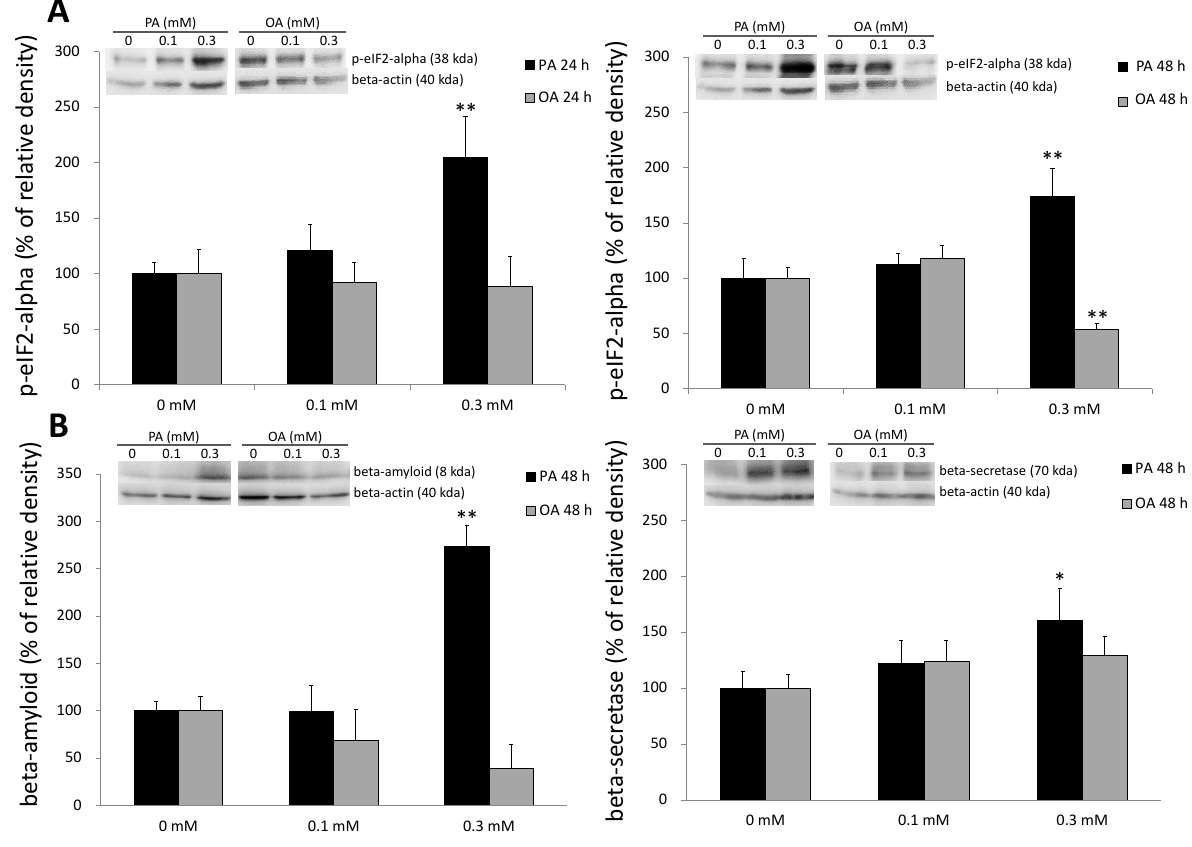
Figure 5. Effects of palmitic acid (PA) and oleic acid (OA) on Alzheimer’s disease pathology-related protein expression and an endoplasmic reticular (ER) stress marker. ( A ) SH-SY5Y cells were treated with 0.1~0.3 mM PA or OA for 24 ( left ) or 48 h ( right ). Cells were then harvested for the analysis of protein expression of the ER stress marker, p-eukaryotic initiation factor 2-alpha (p-eIF2α) and ( B ) SH-SY5Y cells were incubated with PA or OA for 48 h. Cells were then harvested for examination of beta-amyloid protein expression ( left ). SH-SY5Y cells were incubated with PA or OA for 48 h, and then, the beta-secretase protein expression was examined ( right ). Data were analyzed by a one-way ANOVA, followed by the LSD test, and are presented as the mean ± SD. * p < 0.05 vs the control (0 mM PA; 0 mM OA). ** p < 0.01 vs the control (0 mM PA; 0 mM OA) ( n =